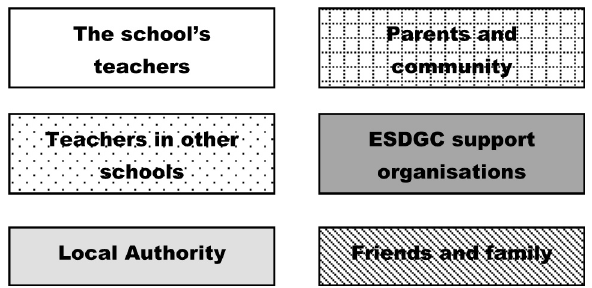
Figure 1: Key to teachers’ external networks (Figures 1a–d) and internal/ external networks (Figure